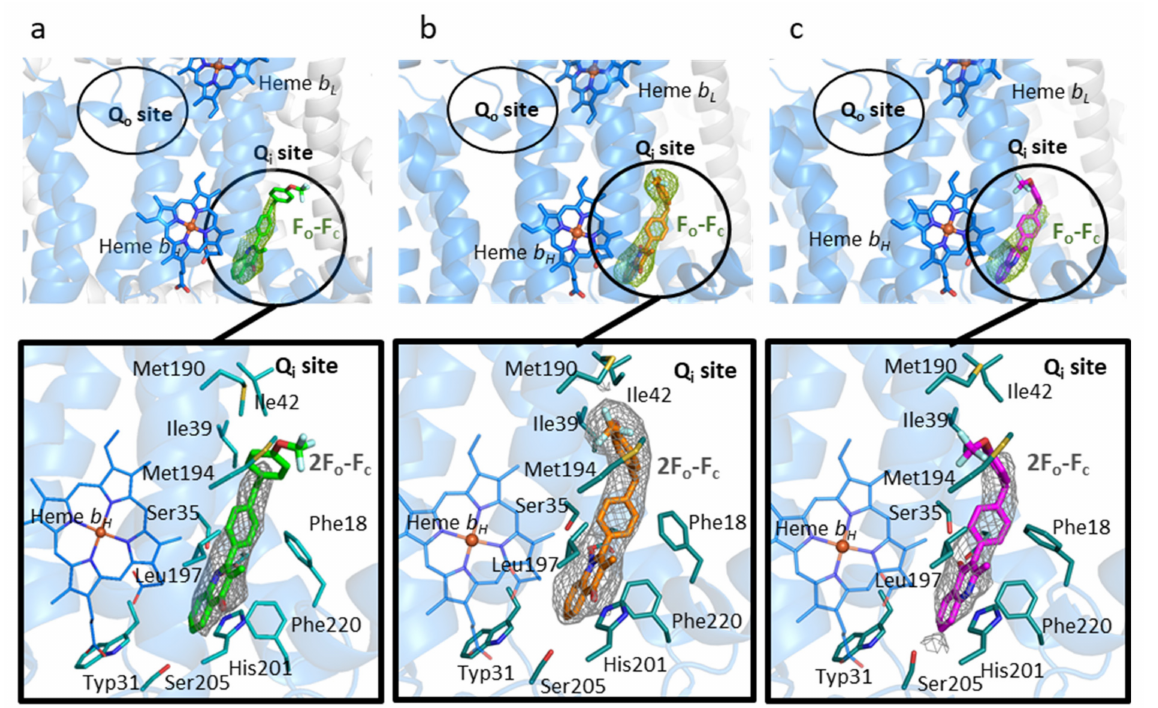
Figure 2. The cytochrome bc 1 Q i site with bound inhibitors ( a ) CK-2-67, ( b ) RKA066, and ( c ) WDH- 1U-4 molecules are shown as green, orange, and magenta sticks, respectively. Upper insert: the omit F o -F c map is contoured at 3 σ level and shown as green mesh. The Q i and Q o sites are marked by black circles. Lower insert: the molecules are shown as sticks surrounded by 2F o -F c electron density contoured at 1 σ level. Q i site residues are shown as blue sticks, hydrogen bonds as black dash lines. The cartoon representation of bovine cytochrome b subunit is shown in